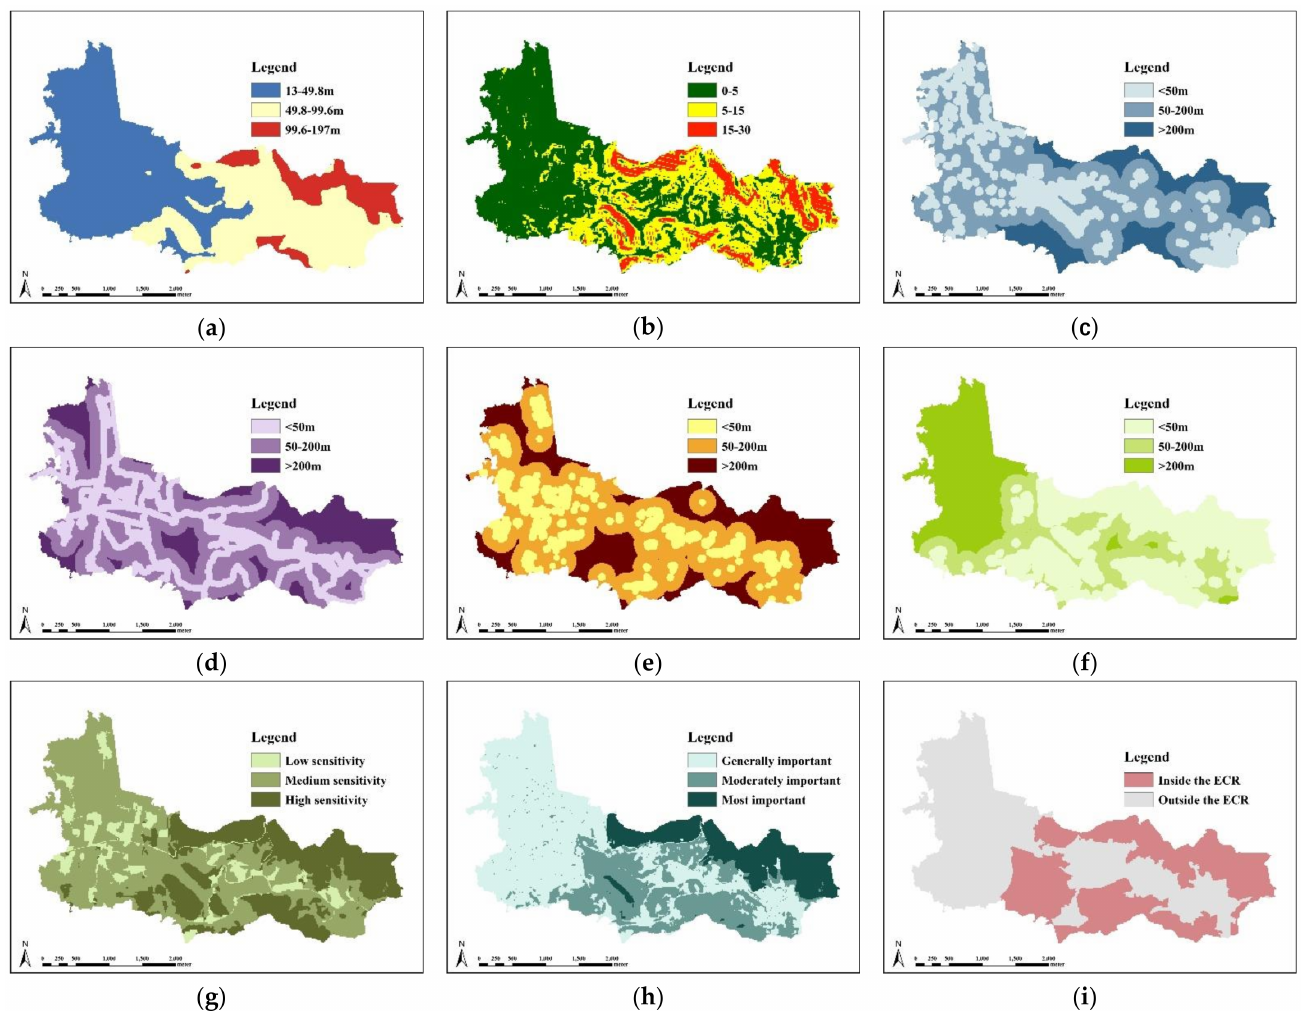
Figure 8. Discrete evidence sample data. ( a ) Altitude; ( b ) Slope; ( c ) Distance from water (2020); ( d ) Distance from roads (2020); ( e ) Distance from buildings (2020); ( f ) Distance from woodland (2020); ( g ) Ecological sensitivity (2020); ( h ) Importance of ESV (2020); ( i )